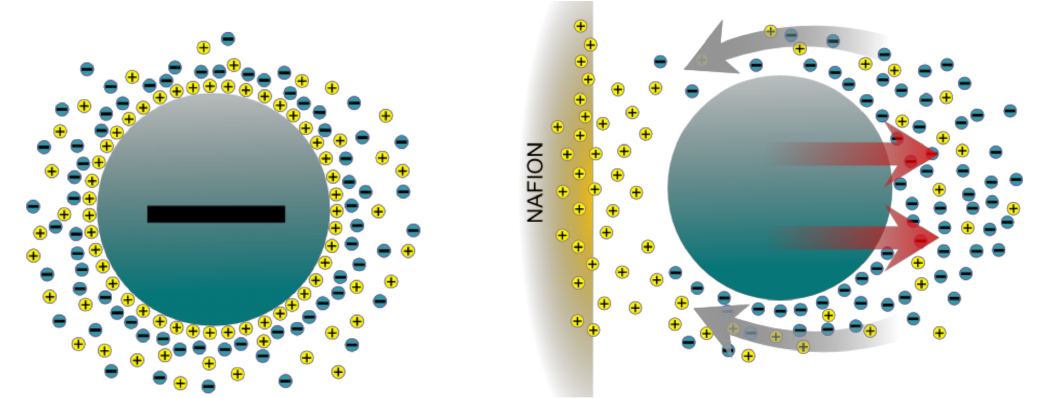
Figure 2. ( left ) Homogeneous case. ( right ) Heterogeneous case leading to